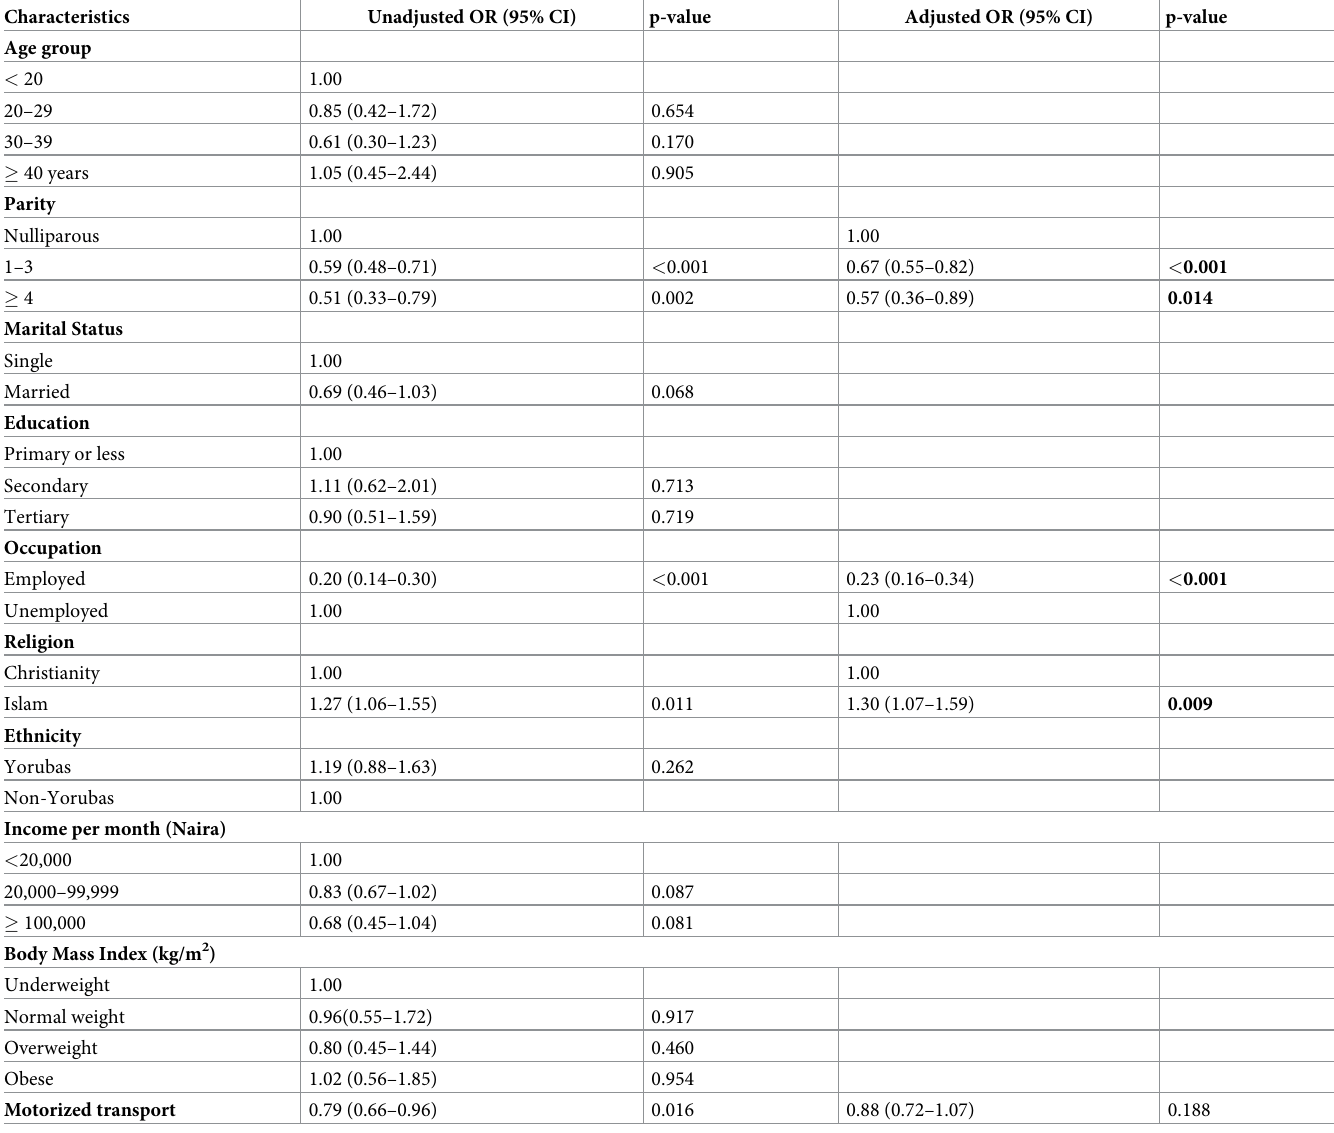
Table 2. Factors associated with inadequate physical activity level among the respondents.